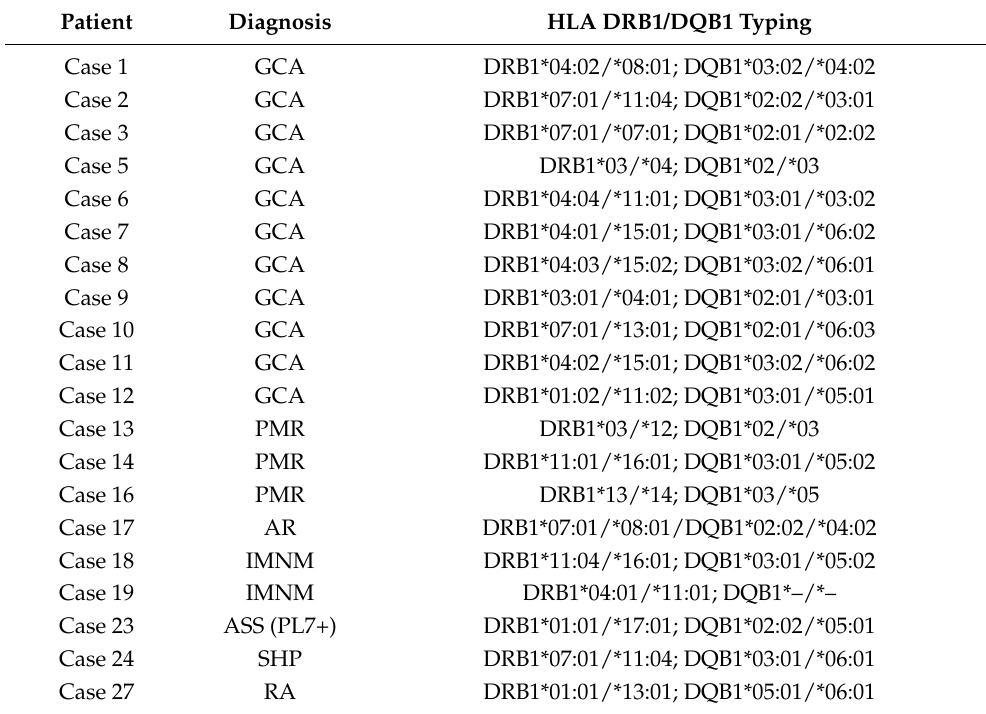
Table 2. DQB1 typing of 20 patients with post-COVID-19 vaccine IMDs.